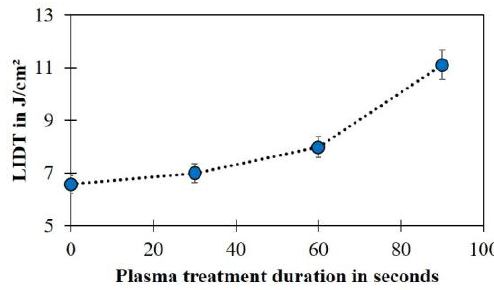
Fig. 5. Laser-induced damage threshold (LIDT) of sapphire surfaces vs. plasma treatment duration